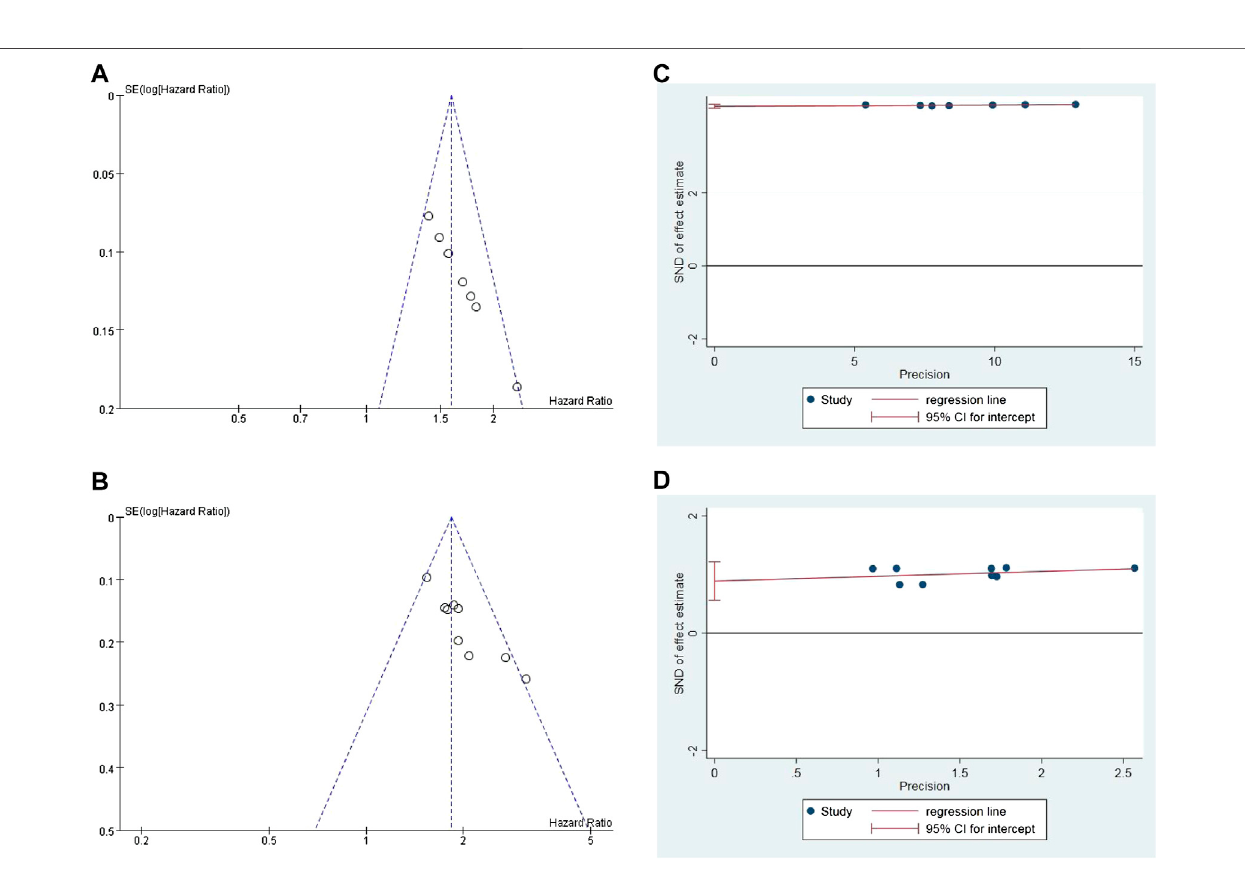
Frontiers in Pharmacology |